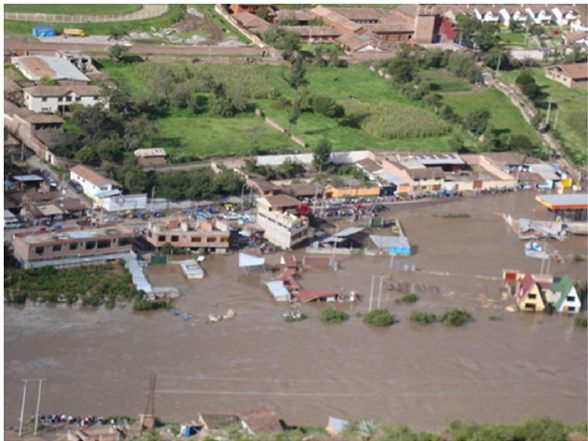
Figure 7. January 2010 floods with parts of the city of Urubamba (provincia of Urubamba, region of Cusco; cf. Fig. 1) inundated by the Vilcanota River (photo: Municipalidad de Urubamba).